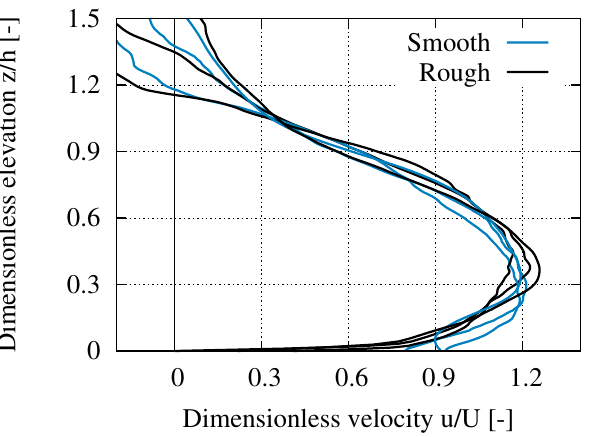
Figure 13. Comparison between density currents flowing over a smooth (experiments S4, S23 and S25) and rough (experiments S26, S27 and S28) bed. All the profiles refer to cross section C5 located in the middle of the straight reach. Figure 12. Comparison between a saline density current (experi- ment S14) and a turbidity current (experiment S25) with suspended = 0 . 0069 sediment performed under the same conditions ( q m 2 / s 0 = 0 . 6 %), measured in cross section C5. and ∆ ρ/ρ 0